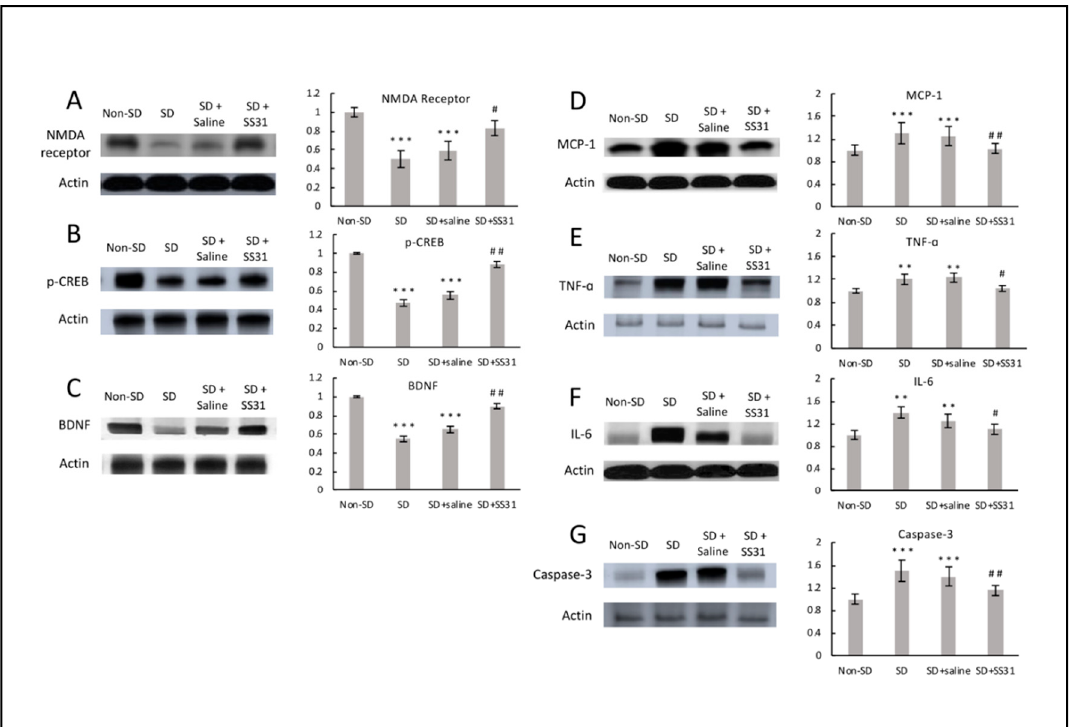
Figure 3. Hippocampal regulatory proteins for synaptic plasticity were restored, and inflammatory cytokines decreased in sleep-deprived mice treated with SS31. Western blotting was performed on hippocampus using specific antibodies for the detection of ( A ) NMDA receptor, ( B ) p-CREB, ( C ) BDNF, ( D ) MCP-1, ( E ) TNF- α , ( F ) IL-6, and ( G ) caspase-3, with Actin used as loading control. The densitometry values for the proteins were normalized to those of Actin, with non-SD group being 1. All data represent the mean ± SEM ( n = 5 per group). ** p < 0.01, *** p < 0.001, statistically significant difference between SD group/SD+Saline group and Non-SD group. # p < 0.05, ## p < 0.01, statistically significant difference between SD+SS31 group and SD group/SD+Saline group.